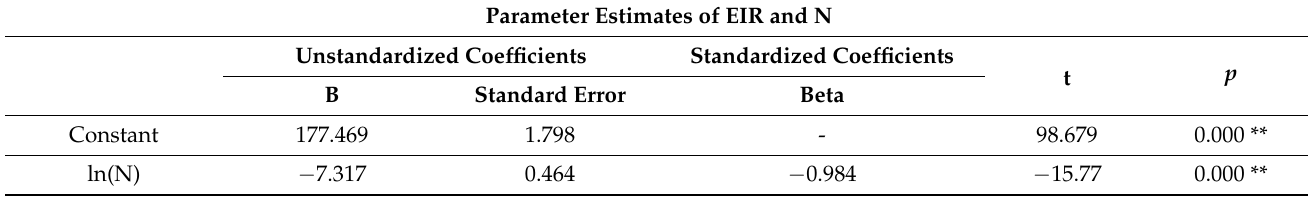
Table 3. Parameter Estimates of EIR and N.